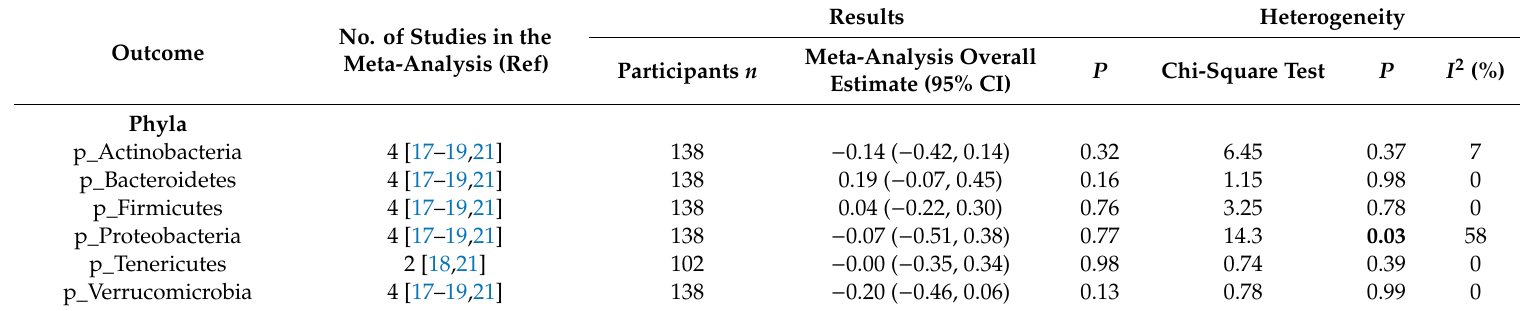
Table 3. Results of meta-analyses comparing nut consumption with control on relative abundance of bacterial taxa at the phylum and genus levels, alpha diversity metrics and stool frequency 1